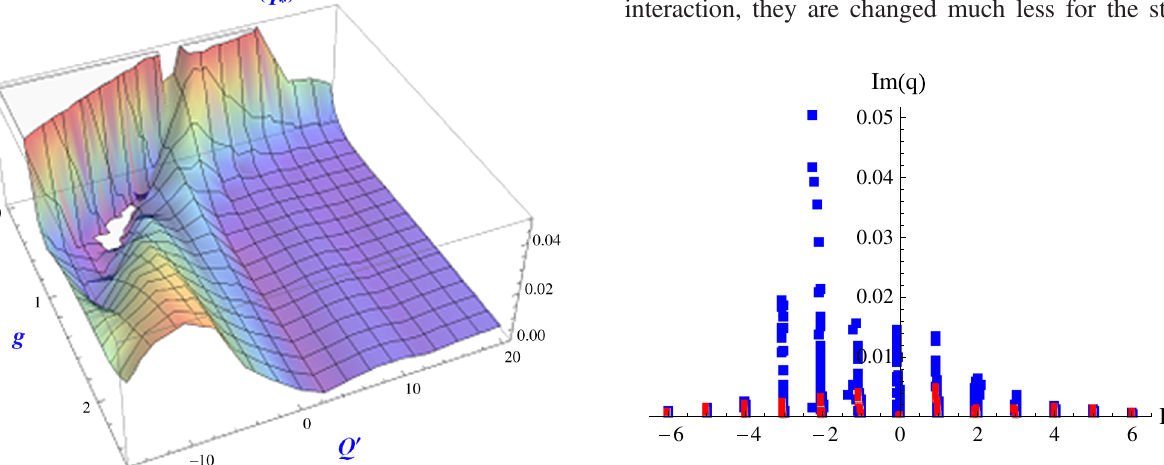
FIG. 10. Two-beam eigenvalues for the same single-beam parameters and color convention as Fig.